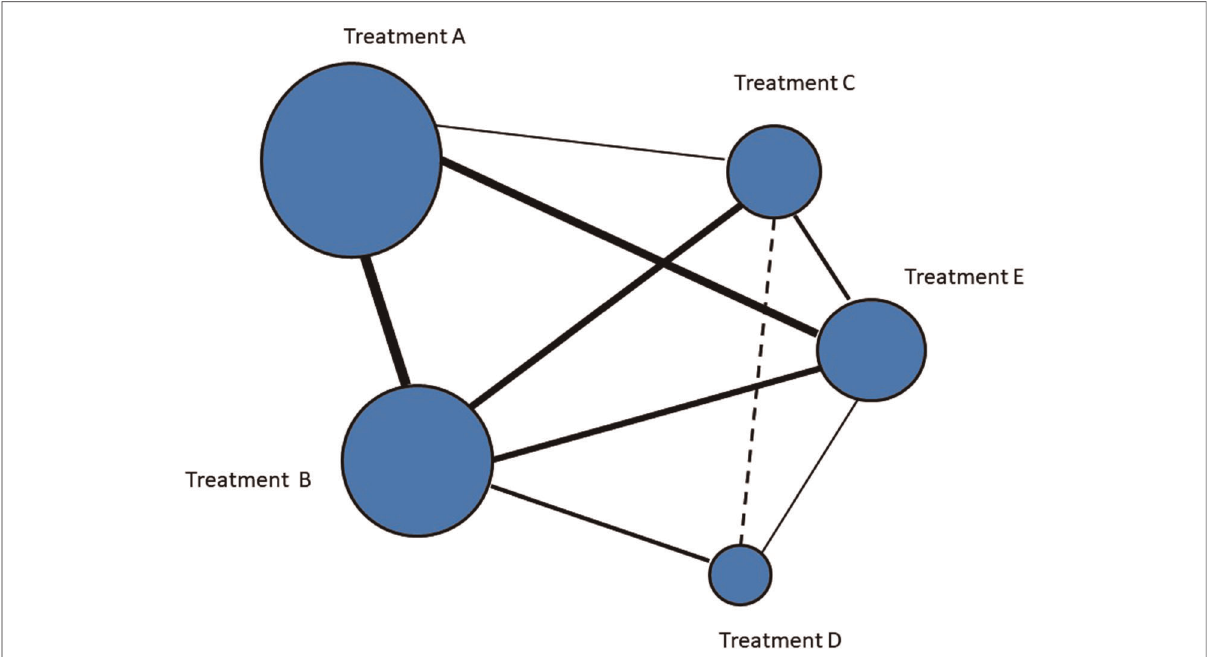
FIGURE 1 Graphical representation of a network meta-analysis: each ellipse (node) represents a treatment, with its size proportional to the number of cohorts in the node. Connections with solid lines between nodes represent direct comparative studies between treatments with the weight of the connecting lines representing the volume of direct comparative evidence. Connections with dashed lines represent indirect